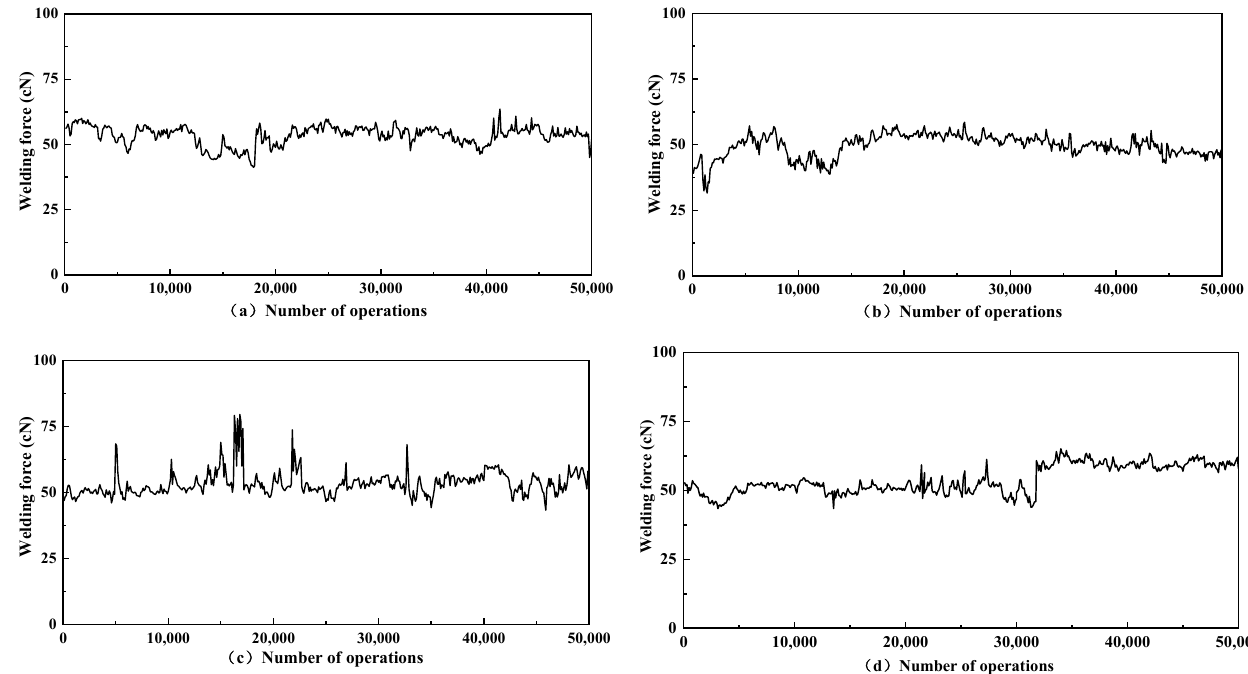
Figure 4. Ag-graphene/Ni contactor welding force: ( a ) AgNi15-5 mg GO, ( b ) AgNi15-10 mg GO, ( c ) AgNi15-20 mg GO, ( d ) Table 2. Average welding force and variance of the Ag-graphene/Ni. Samples